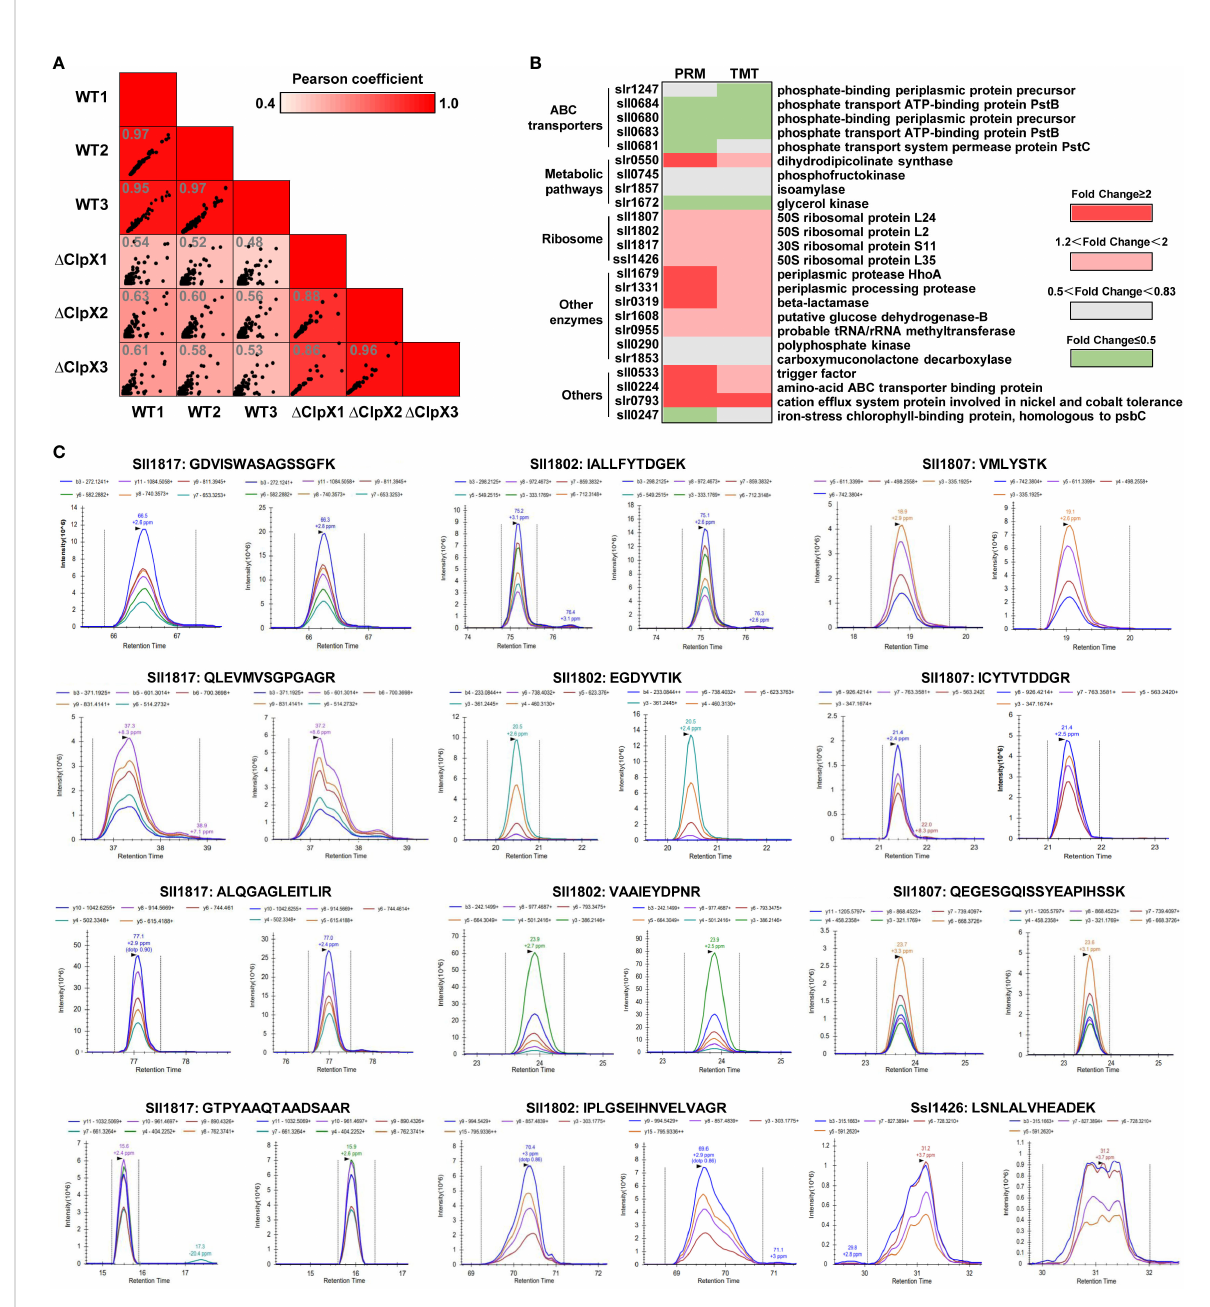
FIGURE 5 Validation of DEPs using Parallel Reaction Monitoring (PRM) analysis. (A) Pairwise correlation of peak area of transitions for the selected DEPs between three biological replicates. (B) Heatmap showing the expression levels of the DEPs selected for validation by PRM. (C) Chromatograms represent the fragment ion extracted-ion chromatograms (XICs) for the representative peptides from the WT and D ClpX